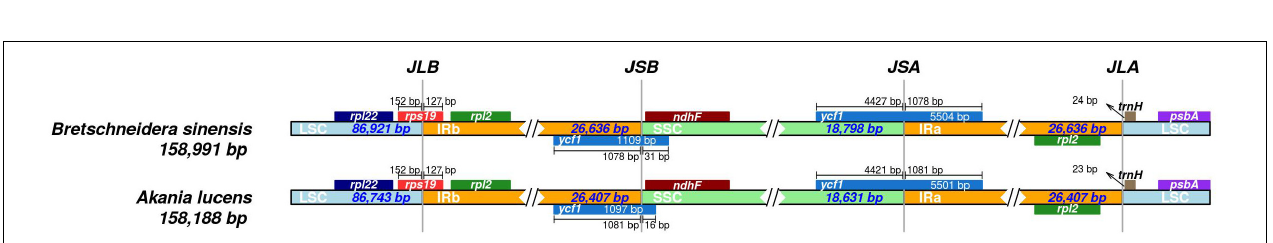
FIGURE 3 | Comparison of the border positions of the LSC, SSC, and IR regions among the chloroplast genomes of two genera of Akaniaceae.